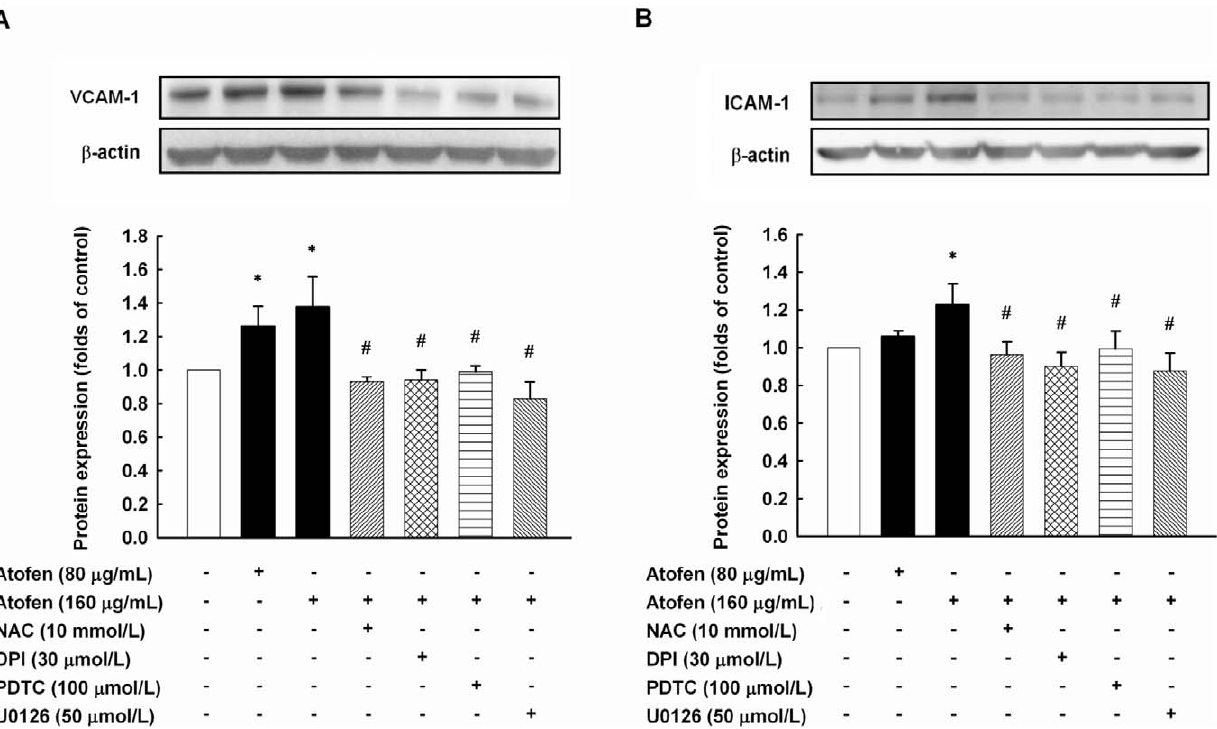
Figure 3. Iron upregulated the expressions of VCAM-1 and ICAM-1 in HAECs. The expressions of VCAM-1 (A) and ICAM-1 (B) in iron- stimulated HAECs were determined by Western blotting. HAECs were treated with ferric chloride hexahydrate (Atofen) with or without NAC (100 mmol/L), DPI (30 m mol/L), PDTC (100 m mol/L), and U0126 (50 m mol/L) for 4 hours. Data (mean 6 SEM) are shown as a bar graph of densitometry data from 3 separate experiments. * P , 0.05 compared with baseline without any treatment. # P , 0.05 compared with 160 m g/mL ferric chloride hexahydrate for 4 h. Abbreviations: DPI, diphenyleneiodonium; HAECs, human aortic endothelial cells; ICAM-1, intracellular cell adhesion molecule-1; NAC, N-acetylcysteine; PDTC, pyrrolidine dithiocarbamate; VCAM-1, vascular cell adhesion molecule-1.